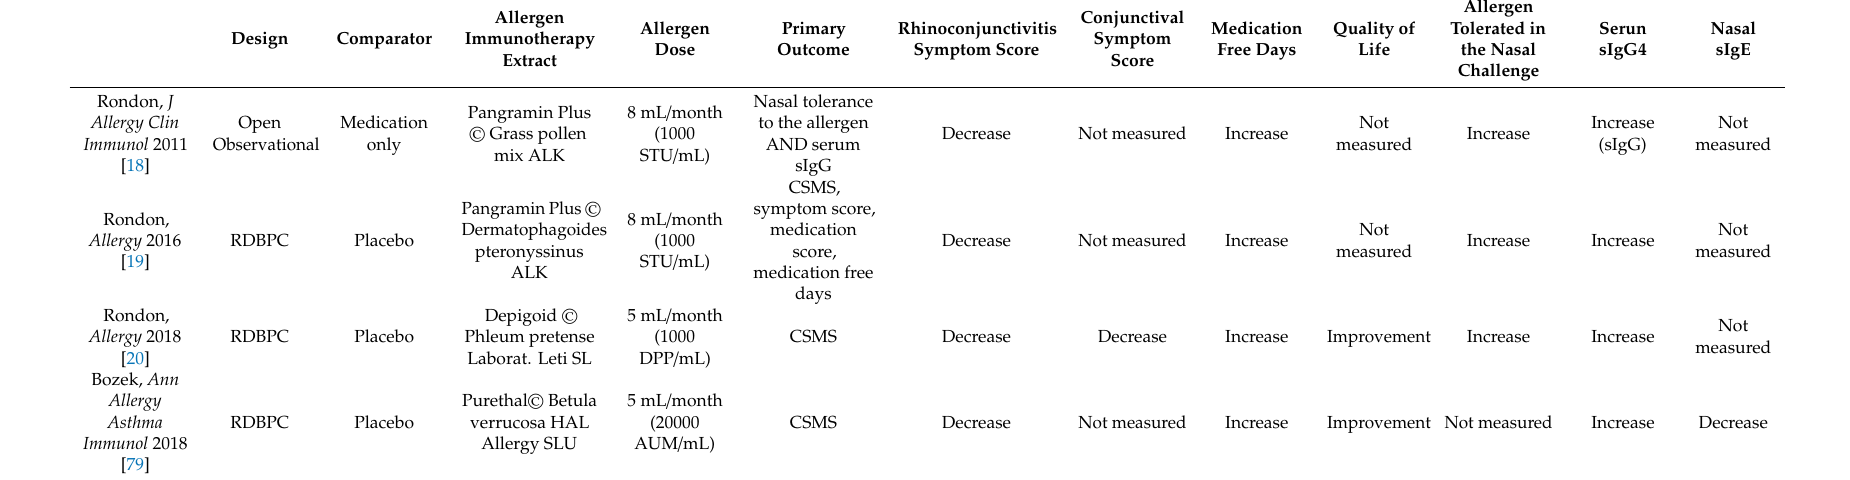
Table 1. Summary of the major findings of the studies investigating the e ff ect of allergen immunotherapy in local allergic rhinitis; RDBPC: randomized, double-blind, placebo controlled; CSMS: combined symptom and medication score; sIgG 4 / IgG / IgE: allergen-specific IgG 4 / IgG / IgE; STU, DPP and AUM are standardization units used by ALK, Leti and Hal Allergy,